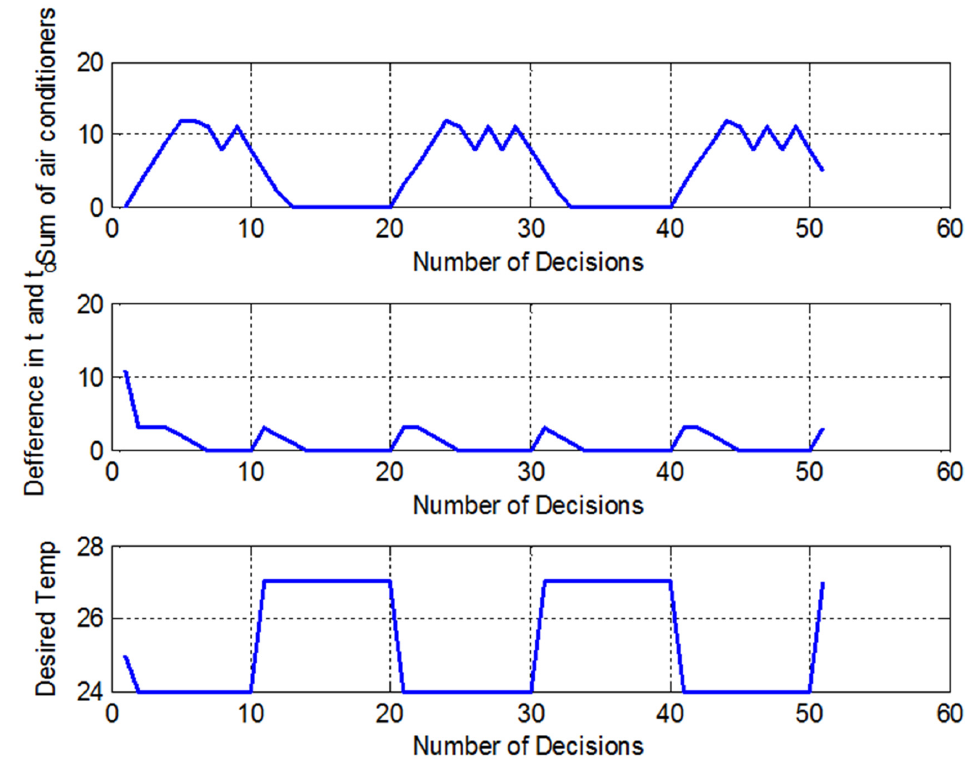
Figure 8. Desired temperature.